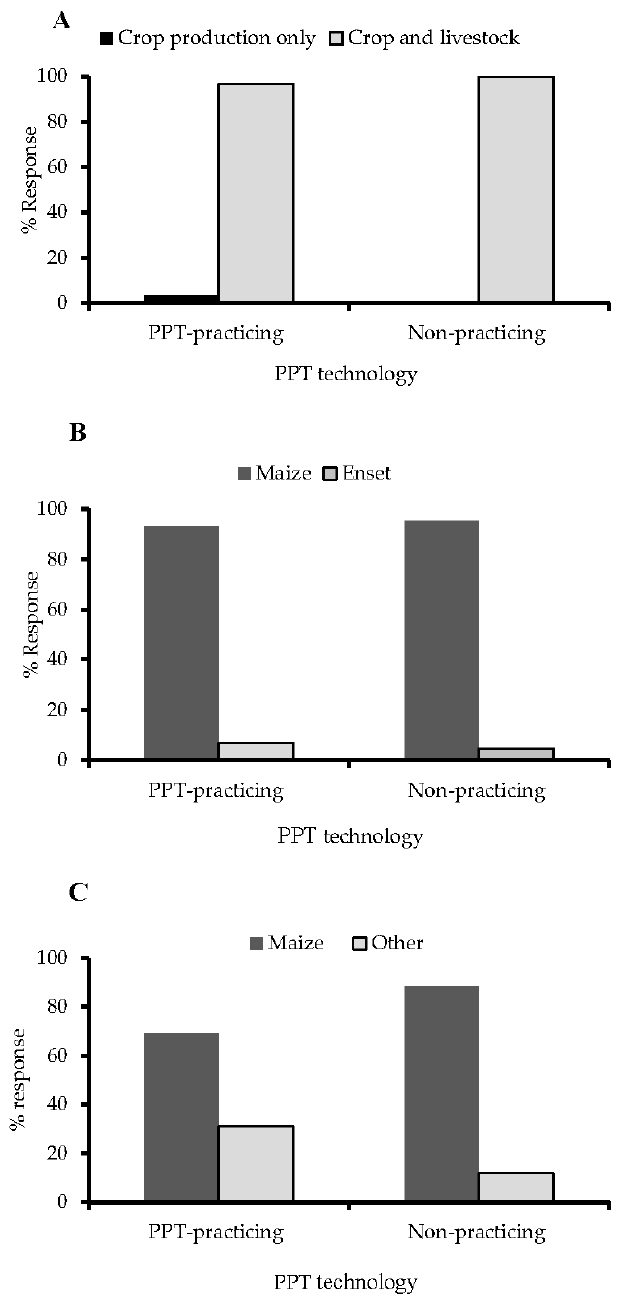
Figure 3. ( A ) Farming systems, ( B ) major food crops grown and ( C ) major cash crops grown in push-pull technology (PPT)-practicing and non-practicing plots in the Hawassa district, Ethiopia.